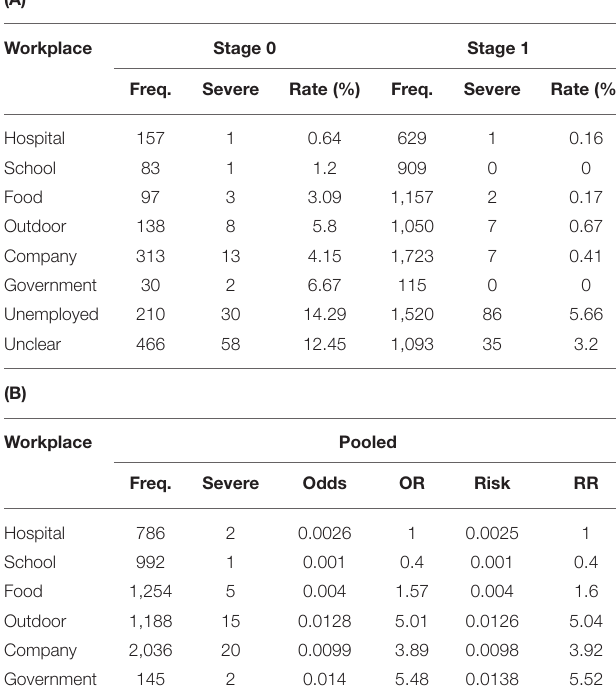
TABLE 4 | Frequency of cases and severe cases by workplace: (A) By stage. (B) Pooled.